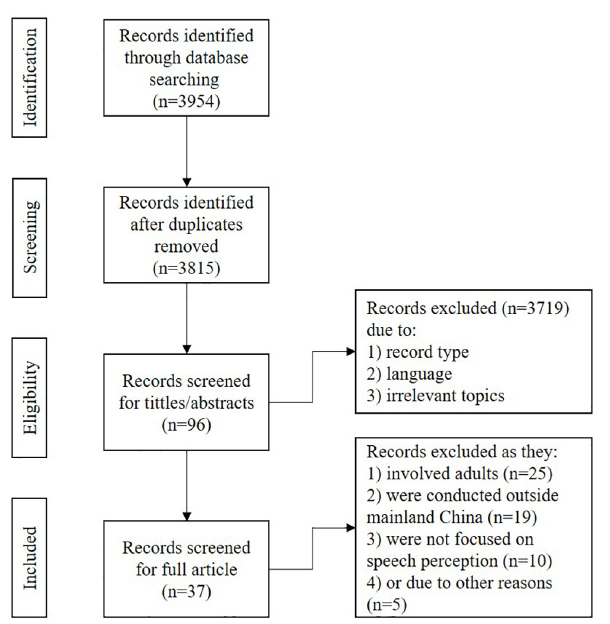
FIGURE 1 | A flowchart of searching and